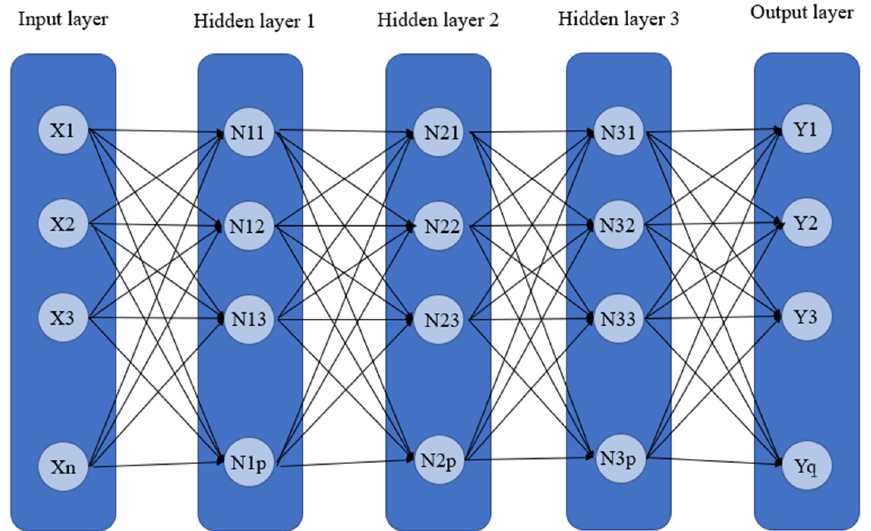
Figure 3. DNN structure.